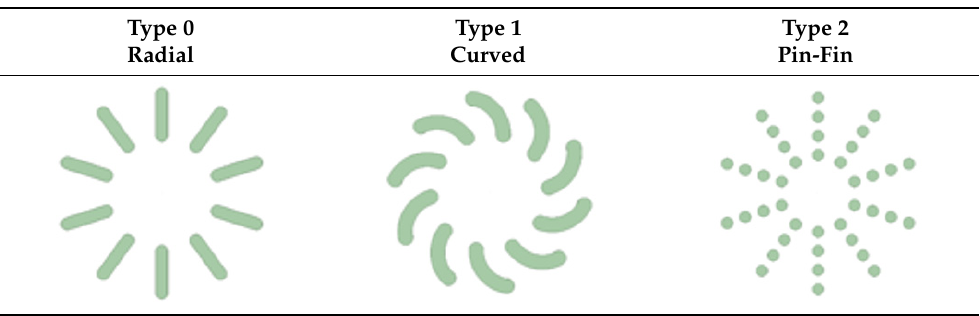
Table 7. Ventilation Blade patterns.